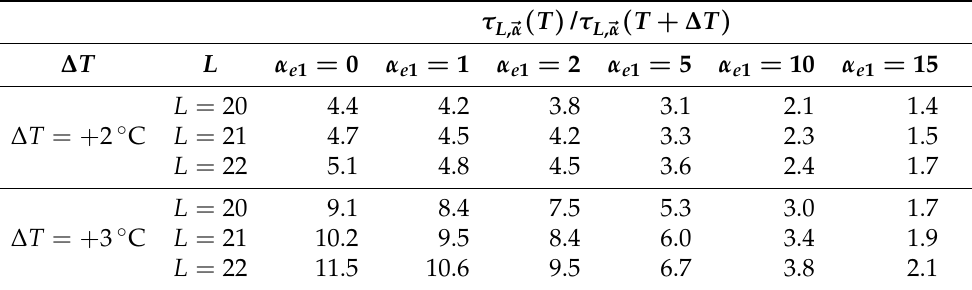
Table A5. Estimation of the relative decrease in the disassociation time τ L , (cid:126) α ( T ) / τ L , (cid:126) α ( T + ∆ T ) , due to a temperature increment ∆ T . The values of the table are computed using Equation (A5), with different values of the increment ∆ T , primer length L , and external mismatch α e 1 in (cid:126) α = ( α e 1 ,0,0 ) , representing different levels of defectiveness of the duplex. T = 55 ◦ C, as a typical PCR